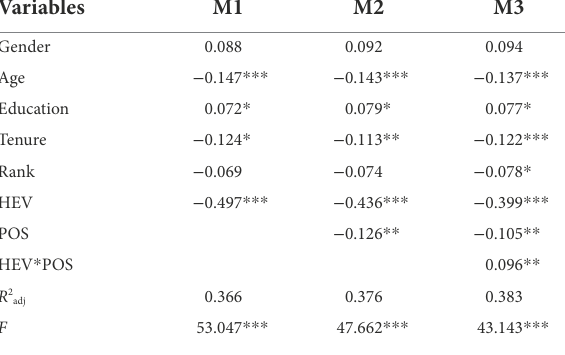
TABLE 5 Results of the moderator.